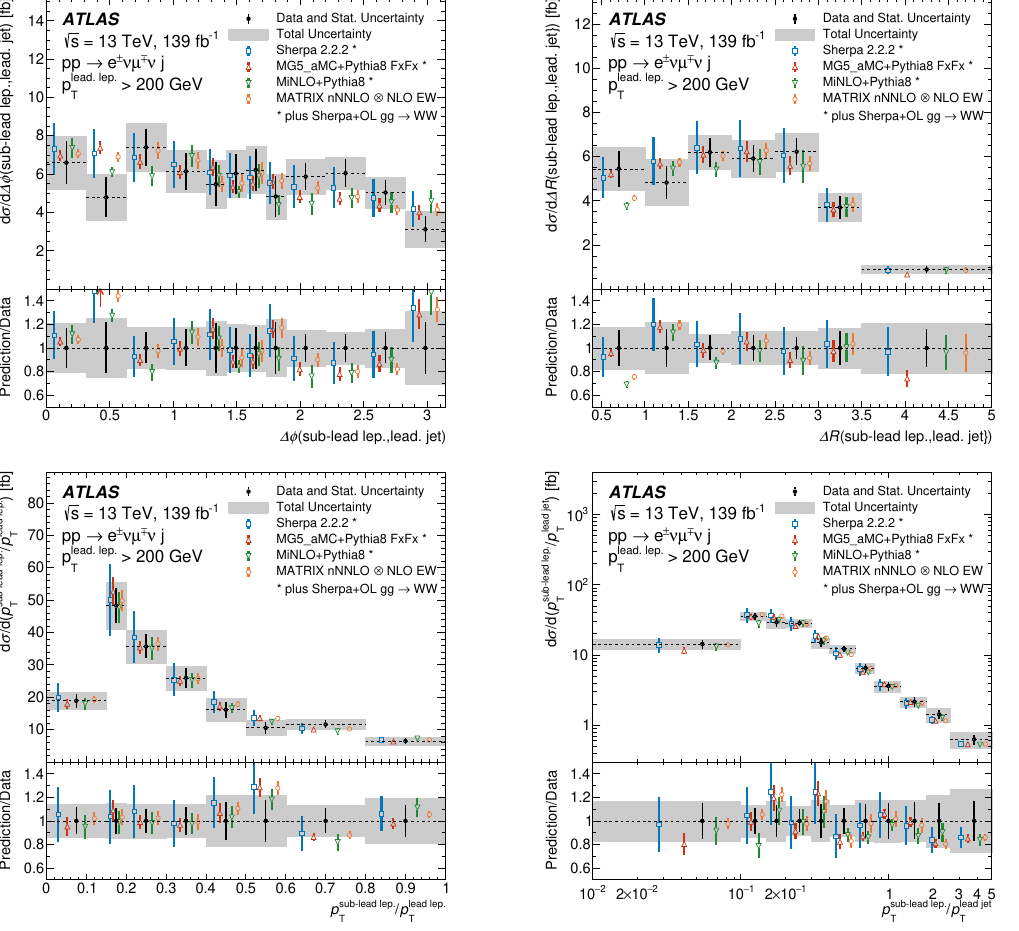
Figure 11 . Measured fiducial cross-sections of WW +jets production for (from left to right and top to bottom): ∆ φ ( sub-lead. lep. , jet ) , ∆ R ( sub-lead. lep. , jet ) , p sub-lead. lep. , and /p lead. lep. T T in the fiducial phase space requiring p lead. lep. p sub-lead. lep. /p lead. jet > 200 GeV. The measured cross- T T T section values are shown as points with error bars giving the statistical uncertainty and solid bands indicating the size of the total uncertainty. The results are compared with the NNLO prediction with extra NLO EW corrections and NLO corrections for gg → WW production (denoted MATRIX ⊗ NLO EW) as well as NLO+PS predictions from Sherpa 2.2.2, MadGraph5 _a MC@NLO + Pythia 8 with FxFx merging, and Powheg MiNLO + Pythia 8 for q ¯ q initial states, combined with Sherpa + OpenLoops (LO+PS) for the gg initial state. The Sherpa 2.2.2 + OpenLoops prediction is normalized to the total cross-section calculated at NLO in QCD. Theoretical predic- tions are indicated as markers with vertical lines denoting PDF and scale